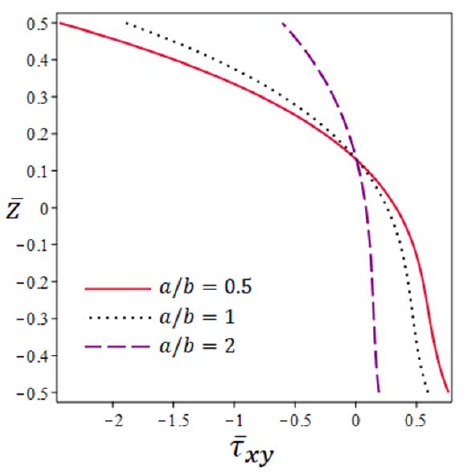
Figure 5: The tangential stress τ xy across the thickness of a FG plate with k = 2 and a / h = 10 .